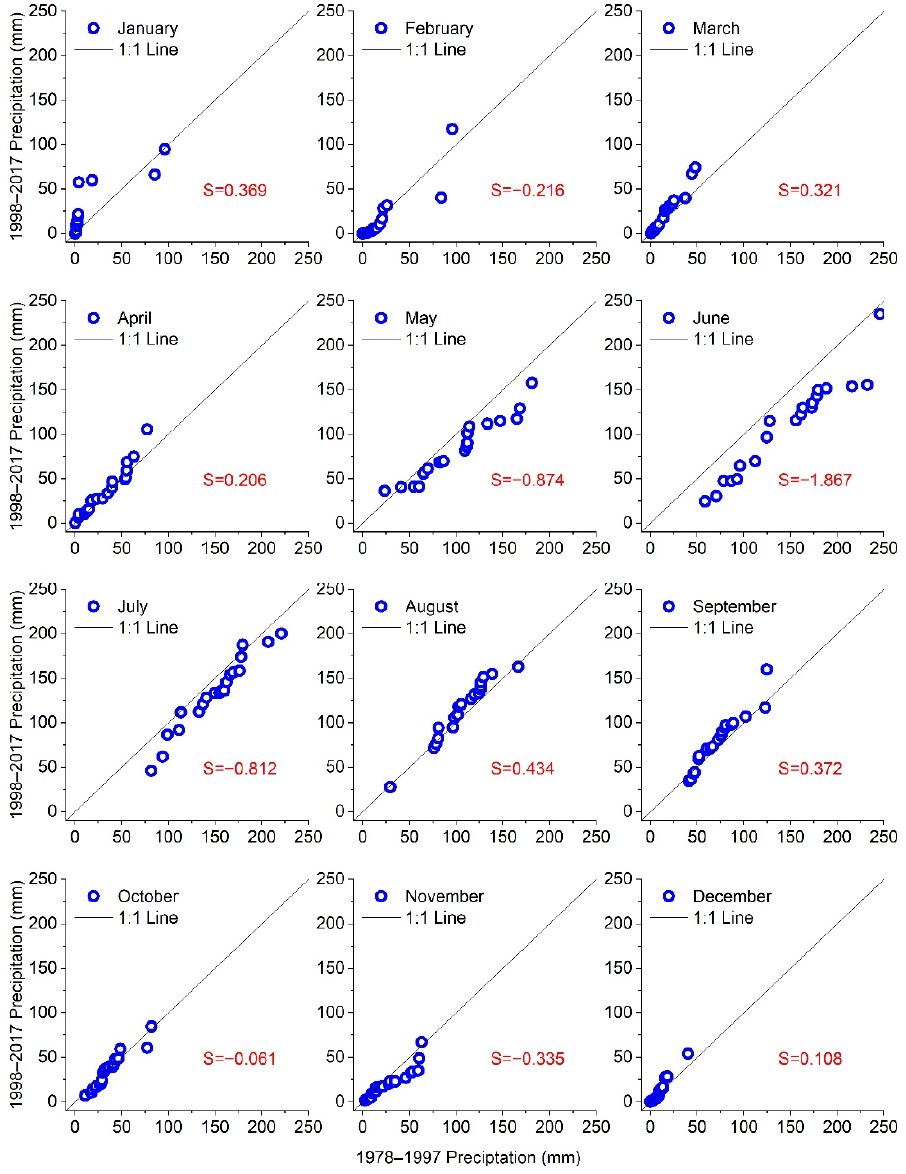
Figure 14. Results of the innovative trend analysis of the annual rainfall in the Gnangara region.